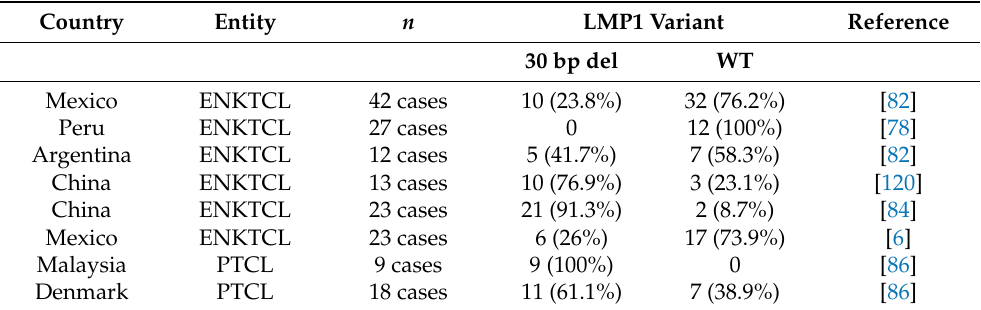
Table 2. Geographical distribution of LMP1 variants in T cell non-Hodgkin